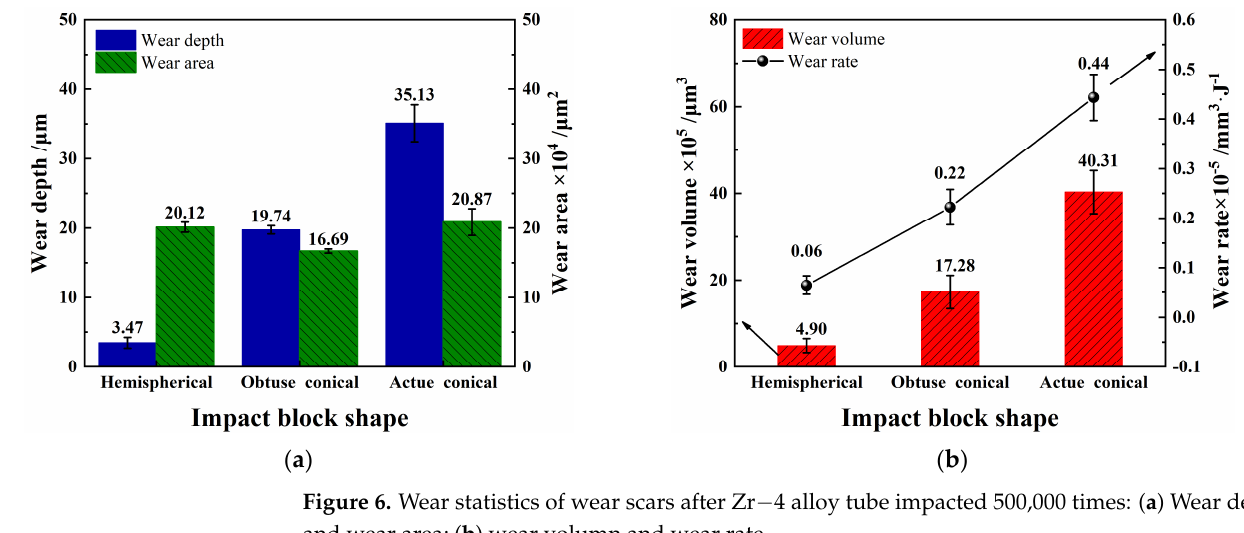
Figure 6. Wear statistics of wear scars after Zr−4 alloy tube impacted 500,000 times: ( a ) Wear depth and wear area; ( b ) wear volumn and wear rate.